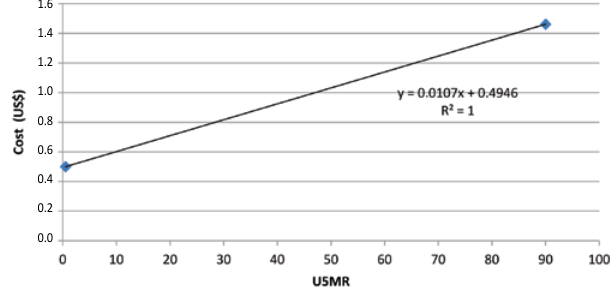
Figure 5 Non–antibiotic cost estimate model.